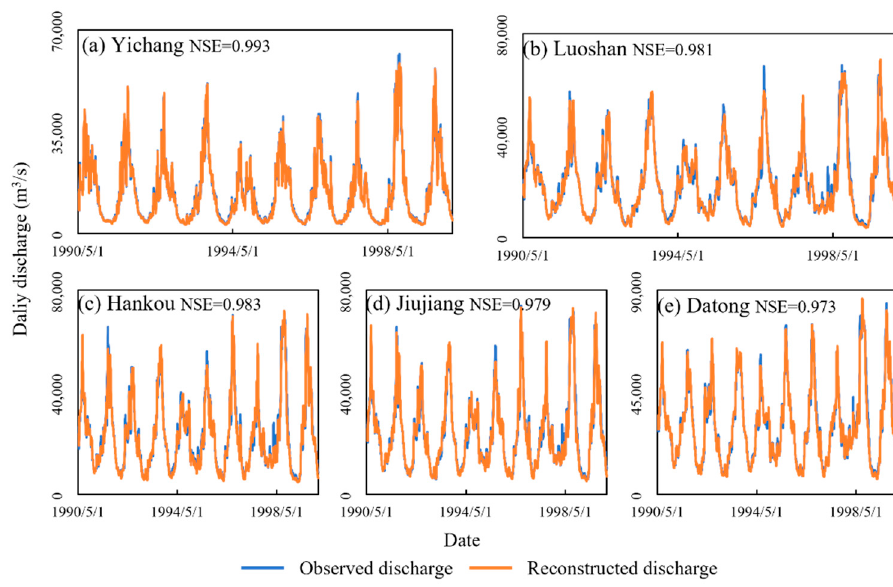
Figure 3. Calibration period from 1 May 1990 to 31 December 1999.